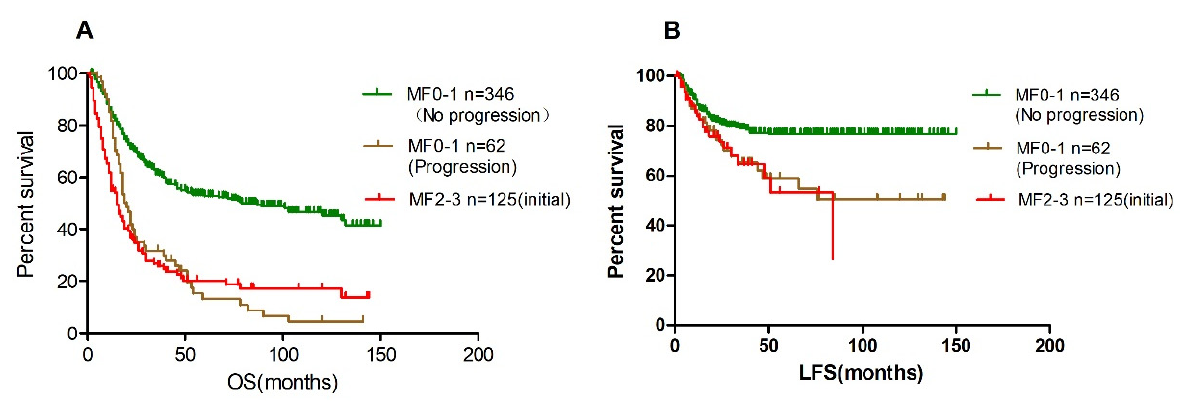
Figure 4. Patients with progressed fibrosis had poor overall survival and leukemia ‐ free survival. ( A ), overall survival; ( B ), leukemia-free ( A ), overall survival; ( B ), leukemia ‐ free survival.